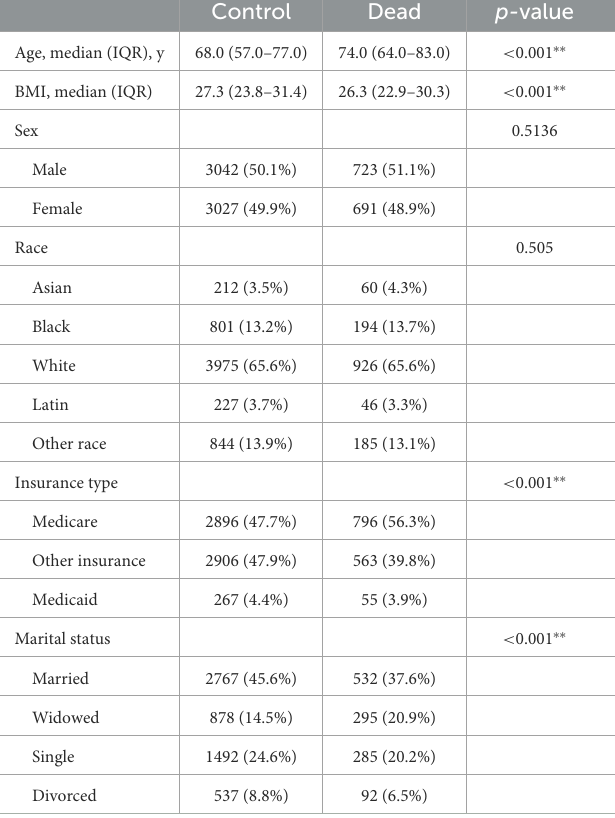
TABLE 1 Comparison of demographic